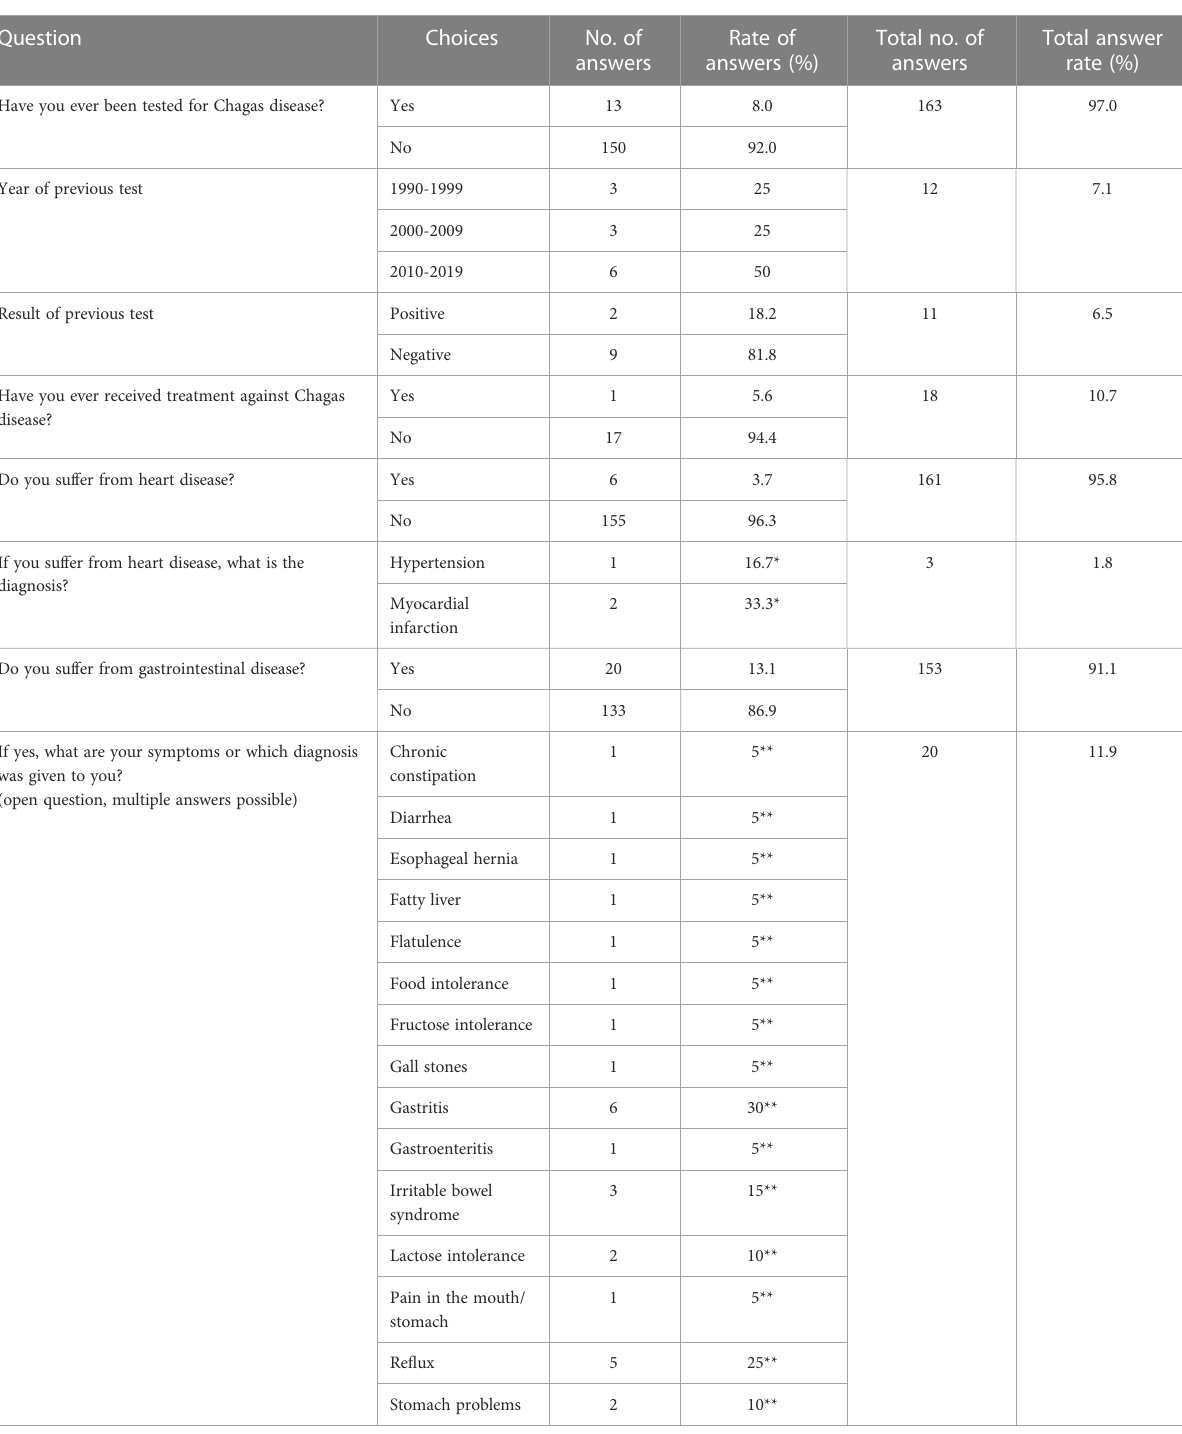
TABLE 5 Medical